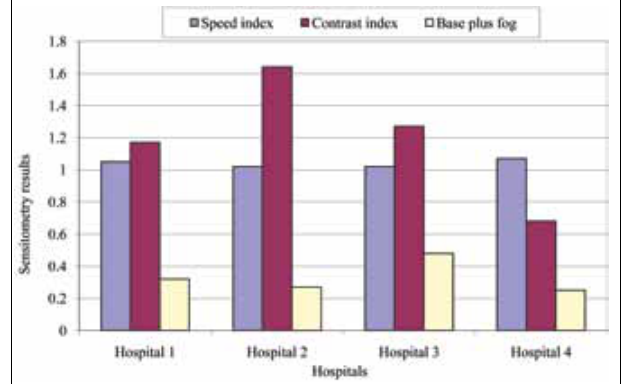
Fig. 3. Mean values of the quality control tests for each film processor.